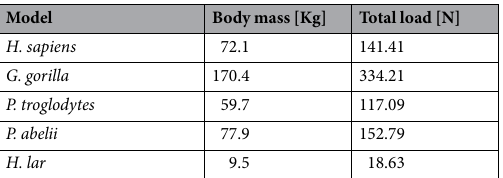
Table 1. Body mass and applied loads for the individuals under